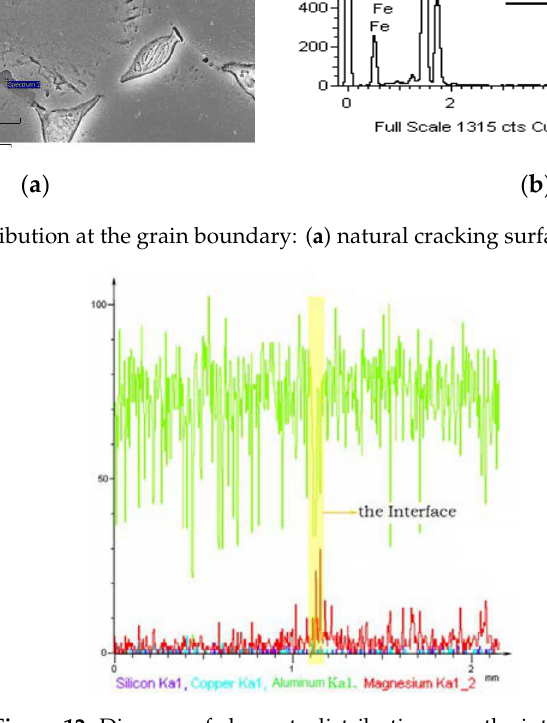
Figure 12. Diagram of elements distribution near the interface.